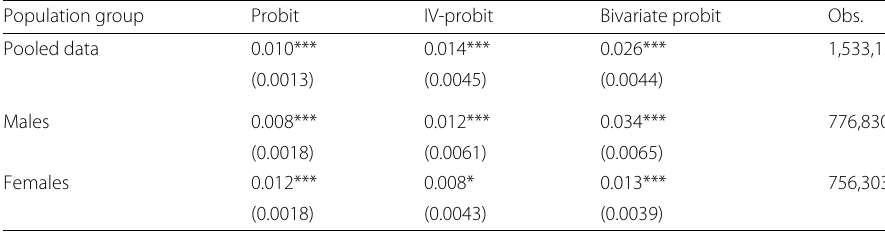
Table 2 Marginal effects of remittances ( 1 / 0 ) on secondary school enrollment ( 1 / 0